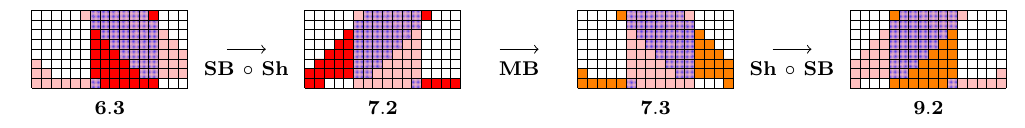
Figure 12: Fitting the two pieces, third edition.